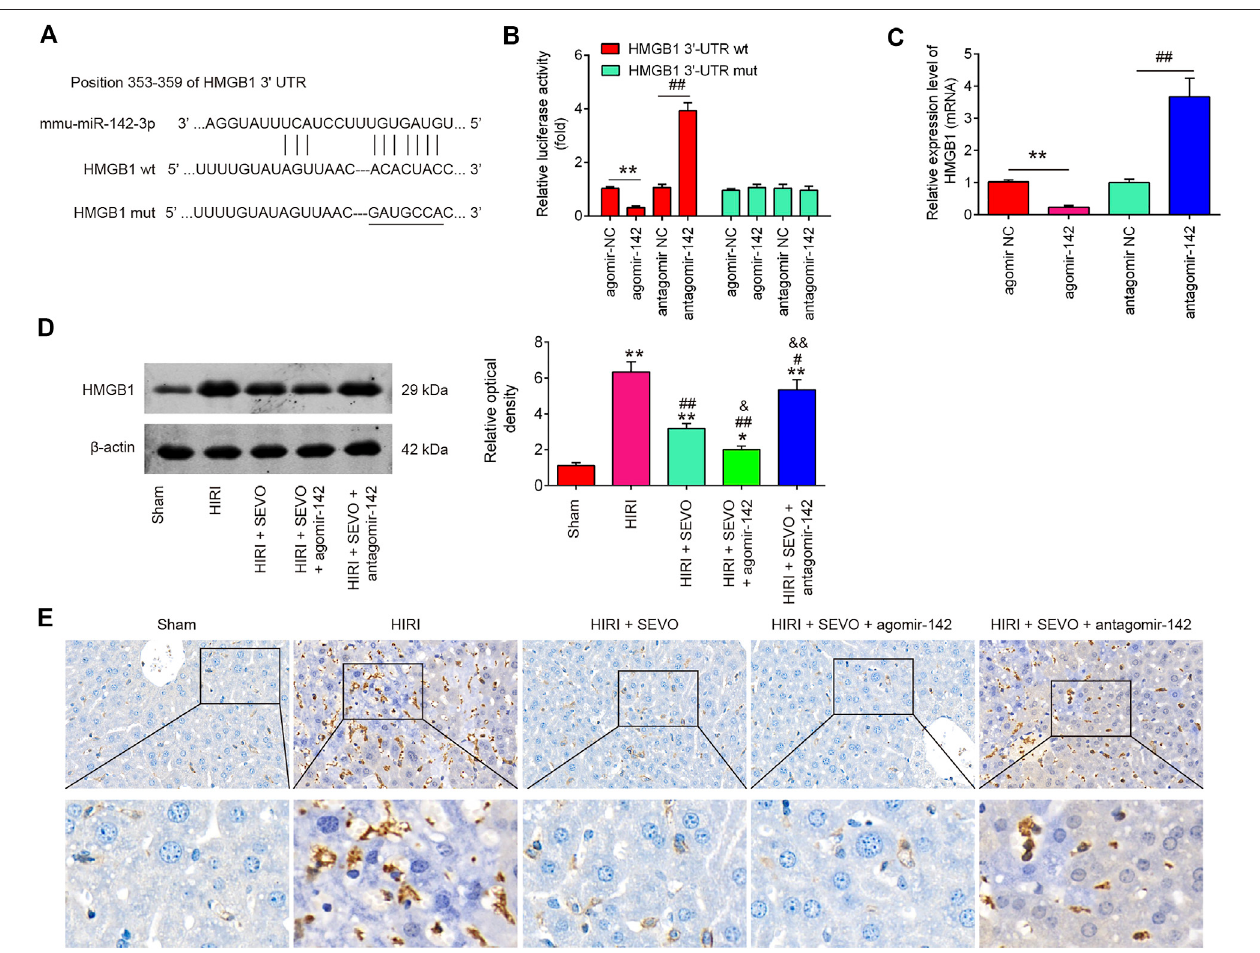
FIGURE 6 | HMGB1 isa direct target ofmiR-142. (A) miR-142-binding sequences in the 3 ′ -UTR of HMGB1 and mutated sites in 3 ′ -UTR ofHMGB1. (B) AgomiR- 142 suppressed the luciferase activities of constructs containing the 3 ′ -UTR segment of HMGB1, while antagomiR-142 signi fi cantly increased the luciferase activities of constructs containing the 3 ′ -UTR segment of HMGB1 ( n (cid:2) 3). (C) The mRNA expressions of HMGB1 were detected by qRT-PCR after treatment with agomiR-142 or antagomiR-142inNCTC1469cells( n (cid:2) 3).Alldataweremeasurementdatawhichwereexpressedasmean ± standarddeviationandanalyzedbyone-wayanalysis ofvariance.** p < 0.01vs.agomiR-NCgroup; ## p < 0.01vs.antagomiR-NCgroup.TheagomiR-142andantagomiR-142wereinjectedintomice( n (cid:2) 6/group),andthen themiceweresubjectedtoischemia, post-treatmentwithinhalationof2%Sevofor2 himmediately attheonsetofreperfusion. (D,E) Theproteinexpression ofHMGB1 was measured by Western Blot and IHC. All data were measurement data which were expressed as mean ± standard deviation and analyzed by one-way analysis